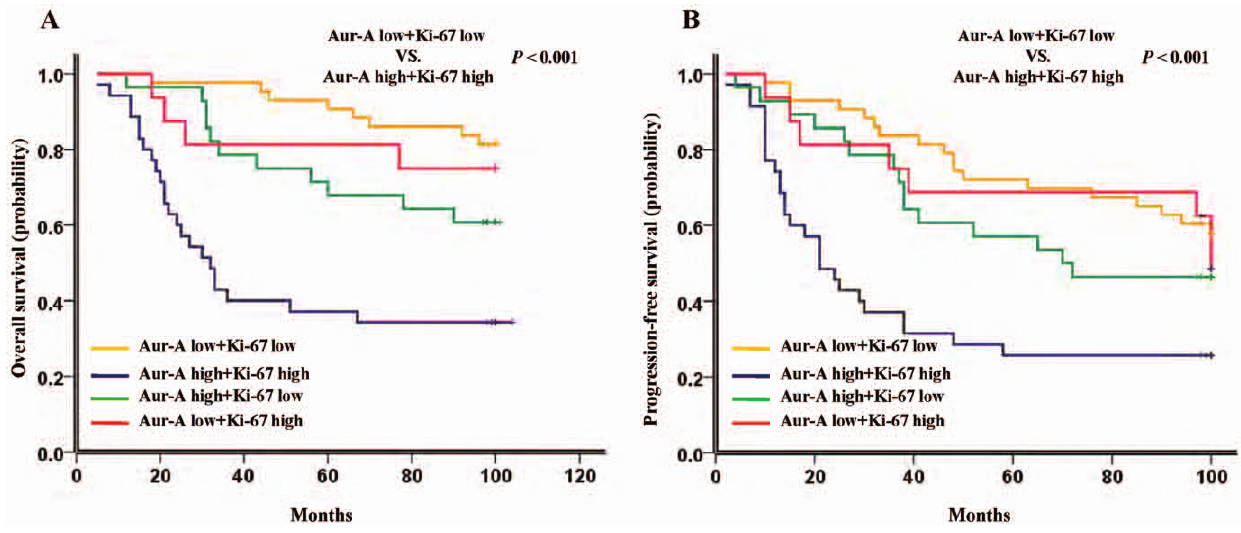
Figure 3. Kaplan-Meier survival analysis of Aur-A and Ki-67 expression in TNBC patients (n=122). (A) TNBC patients with high expression of both Aur-A and Ki-67 showed an inferior overall survival ( P , 0.001), and (B) progression-free survival ( P , 0.001), compared with both Aur-A and Ki-67 low expression. The median survival time for patients with high expression of both Aur-A and Ki-67 VS. low expression of both Aur-A and Ki-67 were 32.5 months VS. 110.0 months for OS ( P , 0.001), and 21.8 months VS. 100.0 months for PFS ( P , 0.001), respectively.